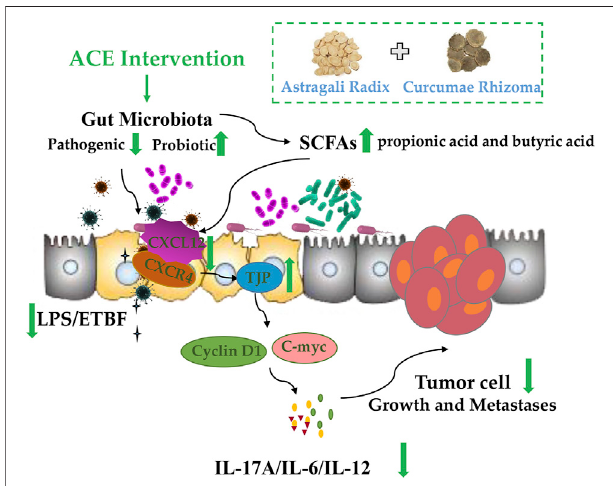
FIGURE 7 | Standardized Astragalus mongholicus Bunge- Curcuma aromatica Salisb. extract ef fi ciently suppresses colon cancer progression through gut microbiota modi fi cation in CT26-bearing